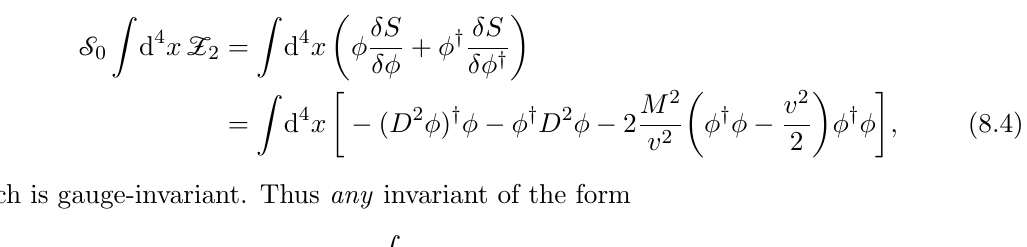
Table 1 . One-loop operator mixing matrix in the Abelian HK model. Shaded entries denote a van- ishing coe(cid:14)cient. The (cid:2) indicates an entry that should vanish according to the non-renormalization theorem of [24, 25] but that does not given the coe(cid:14)cients in eq. (7.1). only via (cid:30) and they are generated by Z (now to be understood in the target theory). In 2 particular one